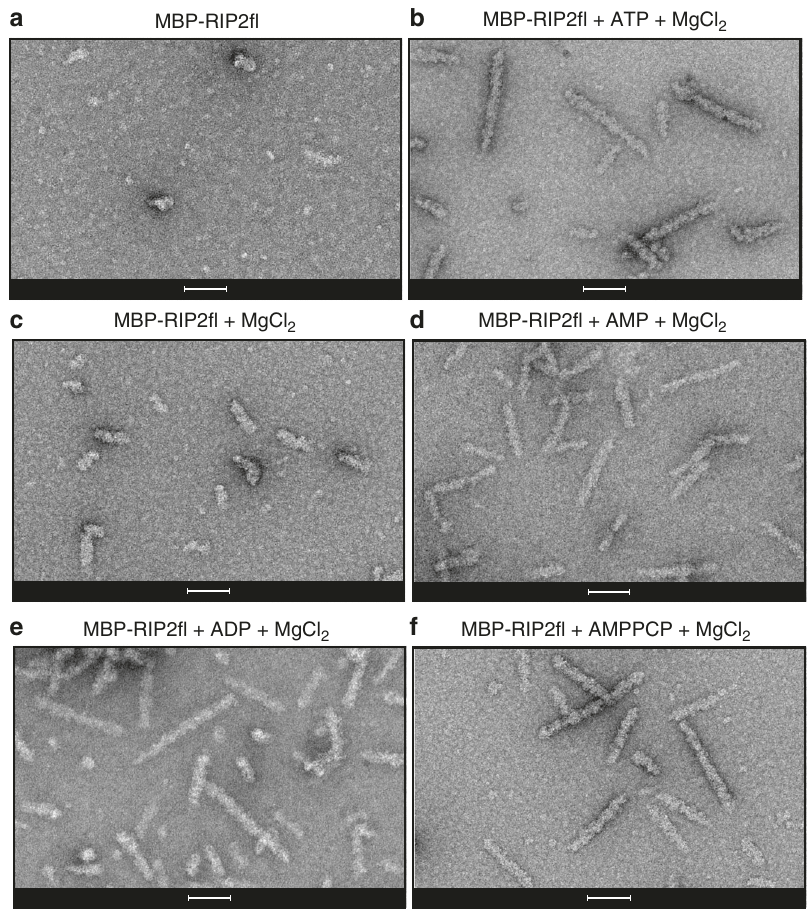
Fig. 2 Full-length RIP2 fi laments are promoted by nucleotide binding. a – c Negative-stain micrographs of MBP-RIP2 fl fi laments obtained from ( a ) MBP- RIP2 fl alone, ( b ) MBP-RIP2 fl plus ATP dissolved in magnesium chloride buffer, ( c ) MBP-RIP2 fl plus magnesium, 5 mM nucleotide dissolved in buffer containing magnesium chloride: ( d ) AMP, ( e ) ADP and ( f ) AMPPCP. Scale bars are 100